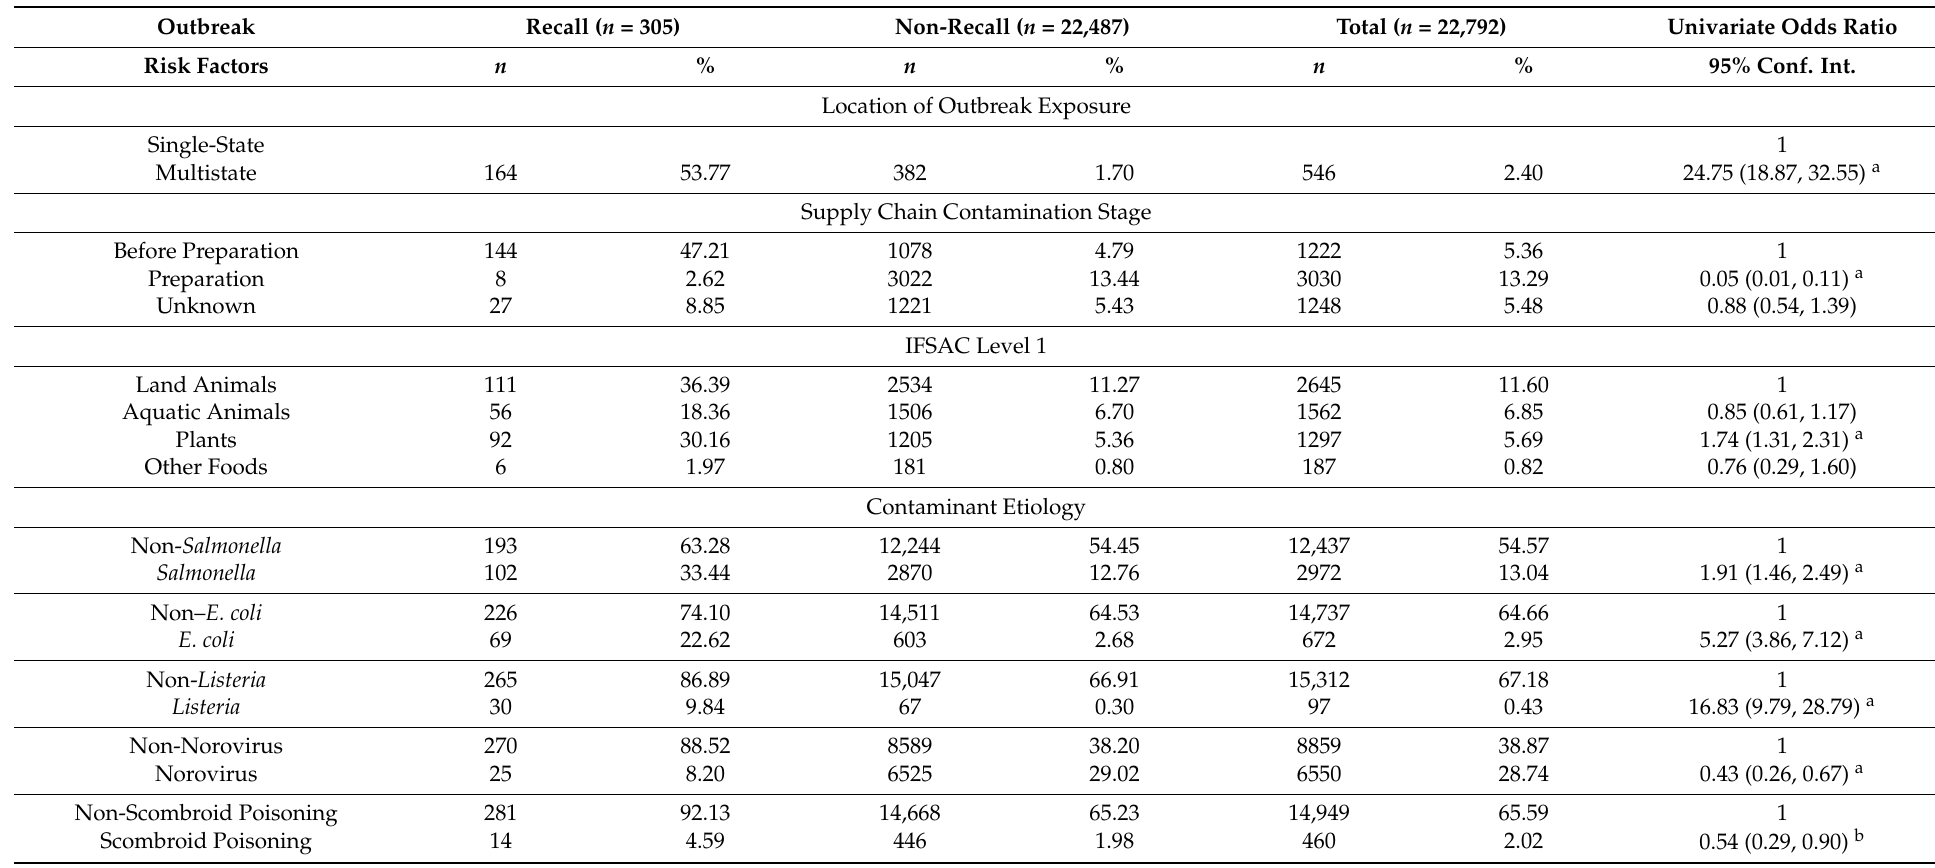
Table 4. Frequency and percentage of foodborne and waterborne outbreaks, overall, by recall status (recall vs. non-recall) and by outbreak risk factors. We extracted data from the electronic Foodborne Outbreak Reporting System (eFORS) and National Outbreak Reporting System (NORS) in 1998–2019. Risk factors include location of outbreak exposure, supply chain contamination stage, Interagency Food Safety Analytics Collaboration (IFSAC) Level 1 food categorization, contaminant etiology, and locations of preparation and consumption of contaminated foods. We supplement descriptive statistics with odds ratio estimates (and 95% confidence intervals) from univariate logistic